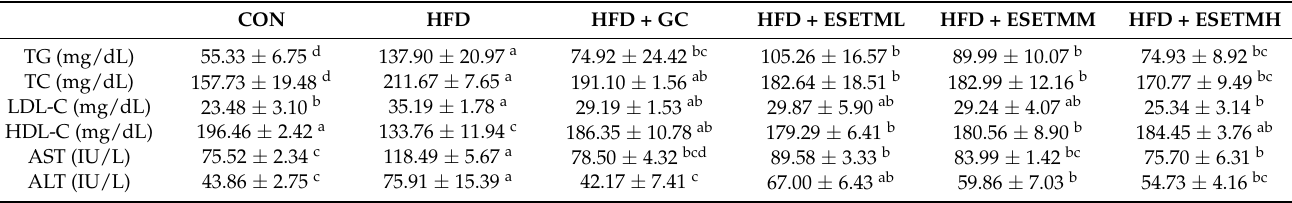
Table 2. Oran weights in ICR mice with ESETM .